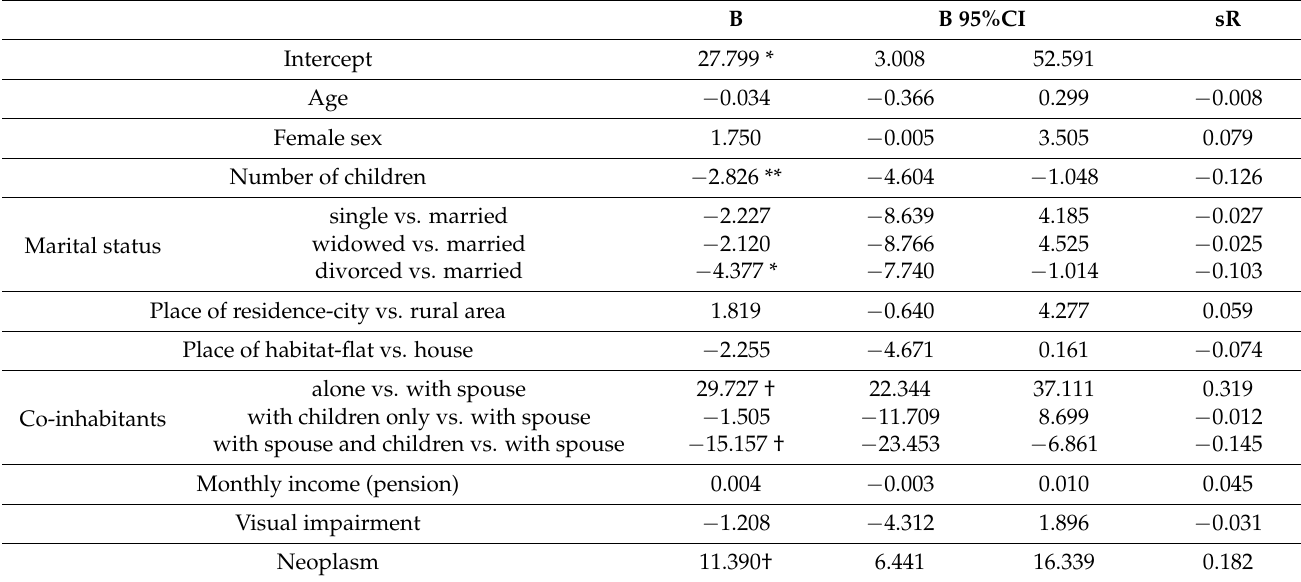
Table 2. Parameters of the linear regression model predicting the De Jong Gierveld Loneliness Scale score in the studied group of the older adults living in the city and in the rural area.